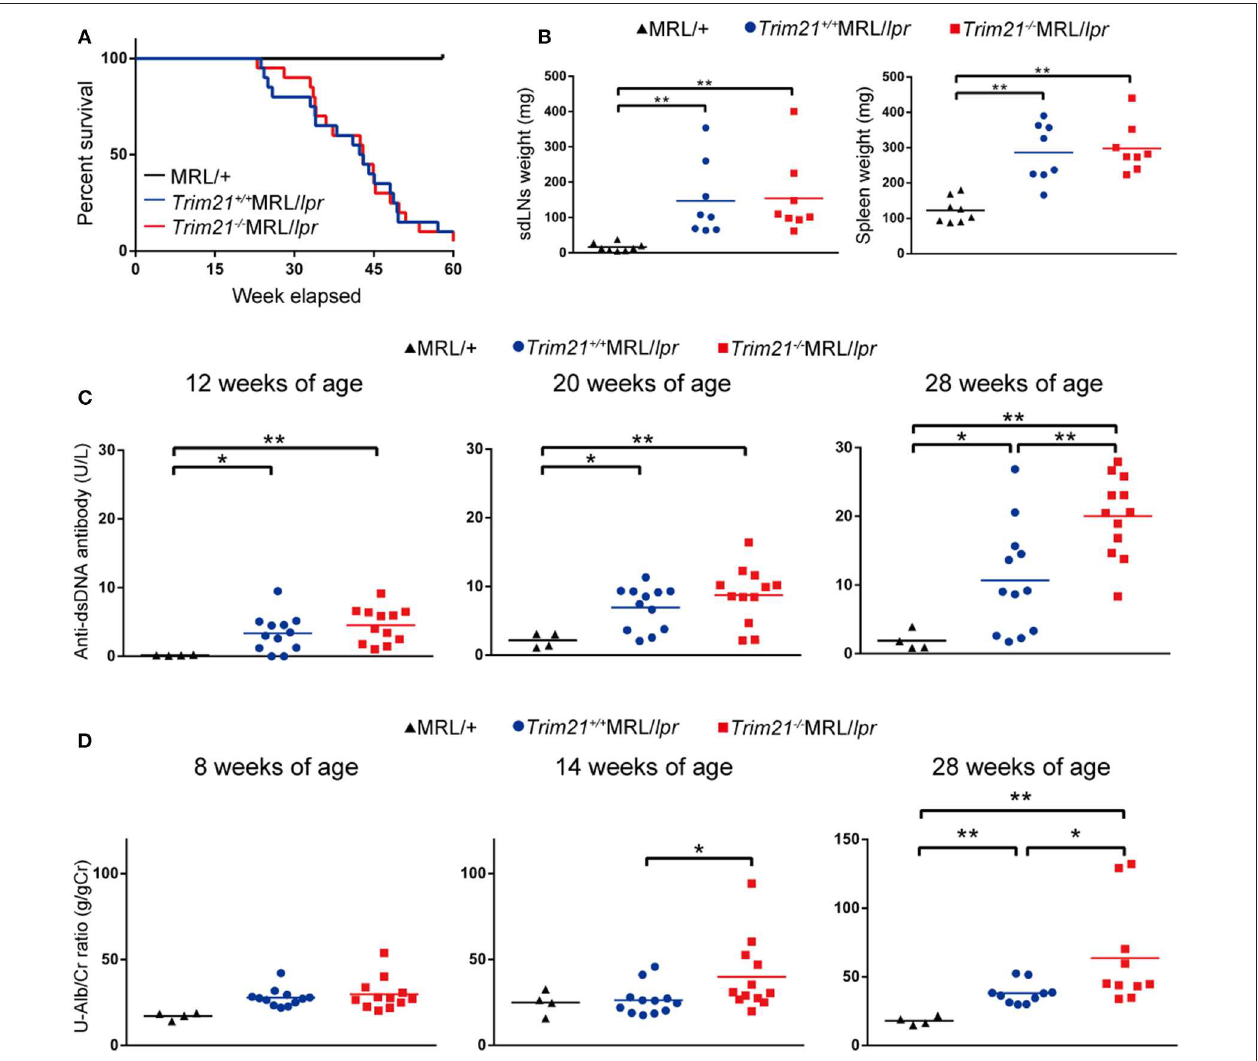
FIGURE 3 | TRIM21 deficiency promotes exacerbation of lupus-like symptoms in MRL/ lpr mice. (A) Survival rates of mice (MRL/ + ; n = 4, Trim21 + / + MRL/ lpr ; n = 20 and Trim21 − / − MRL/ lpr ; n = 20). (B) Weights of sdLNs and spleens at 10 weeks of age ( n = 8 in each group). (C) Concentrations of serum anti-dsDNA Ab were measured by ELISA at 12, 20, and 28 weeks (MRL/ + ; n = 4, Trim21 + / + MRL/ lpr ; n = 12 and Trim21 − / − MRL/ lpr ; n = 12). (D) Proteinuria (albumin-creatinine ratio) was measured at 8, 14, and 28 weeks (MRL/ + ; n = 4, Trim21 + / + MRL/ lpr ; n = 12 and Trim21 − / − MRL/ lpr ; n = 12). Statistically significant data (* p < 0.05 and ** p < 0.01) by Student’s t -test,